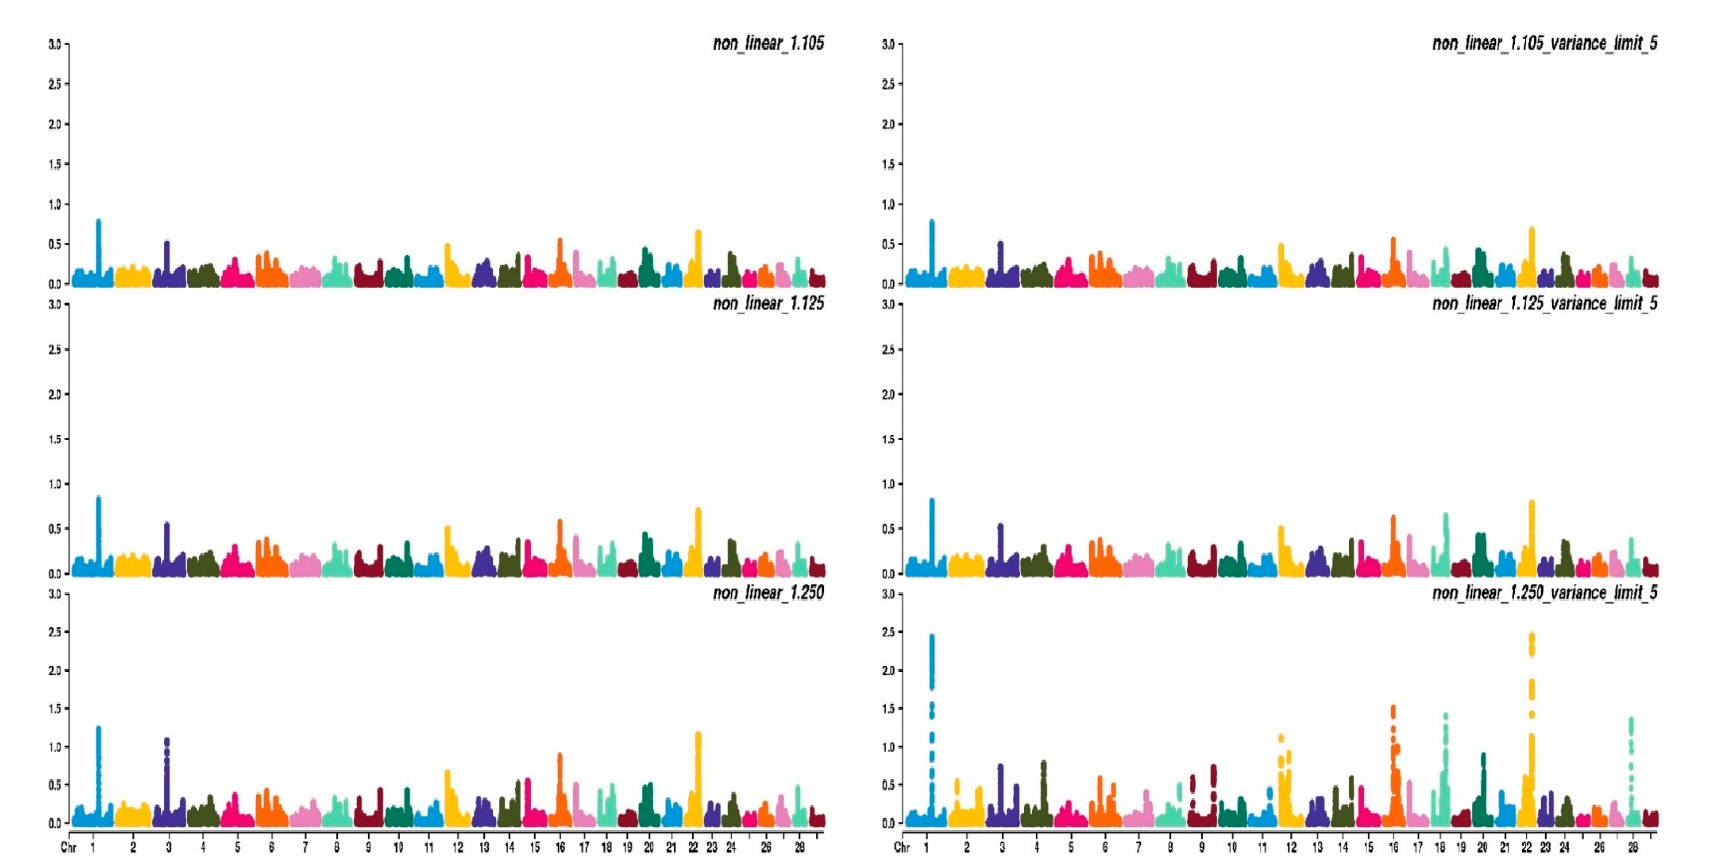
Figure 4. Manhattan plots for fleshiness score (EUROP) using different WssGBLUP strategies in iteration equal to 10; y-axes represent the percentage explained by each SNP. Variance explained was calculated with the sliding window approach.